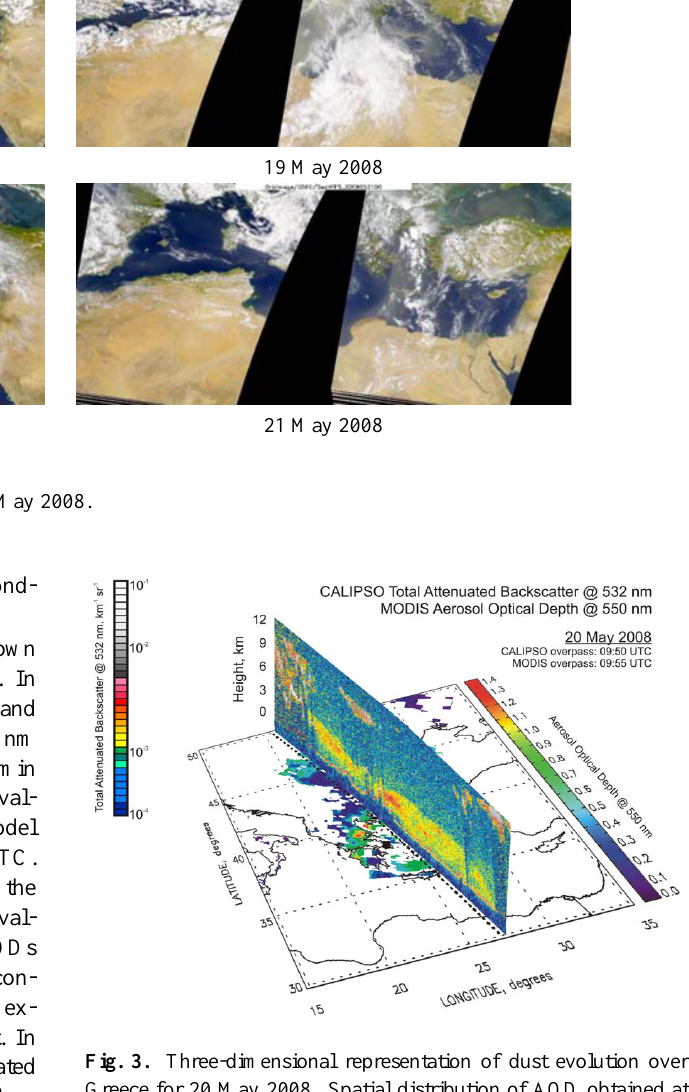
backscatter/Raman lidar measurements are used in this